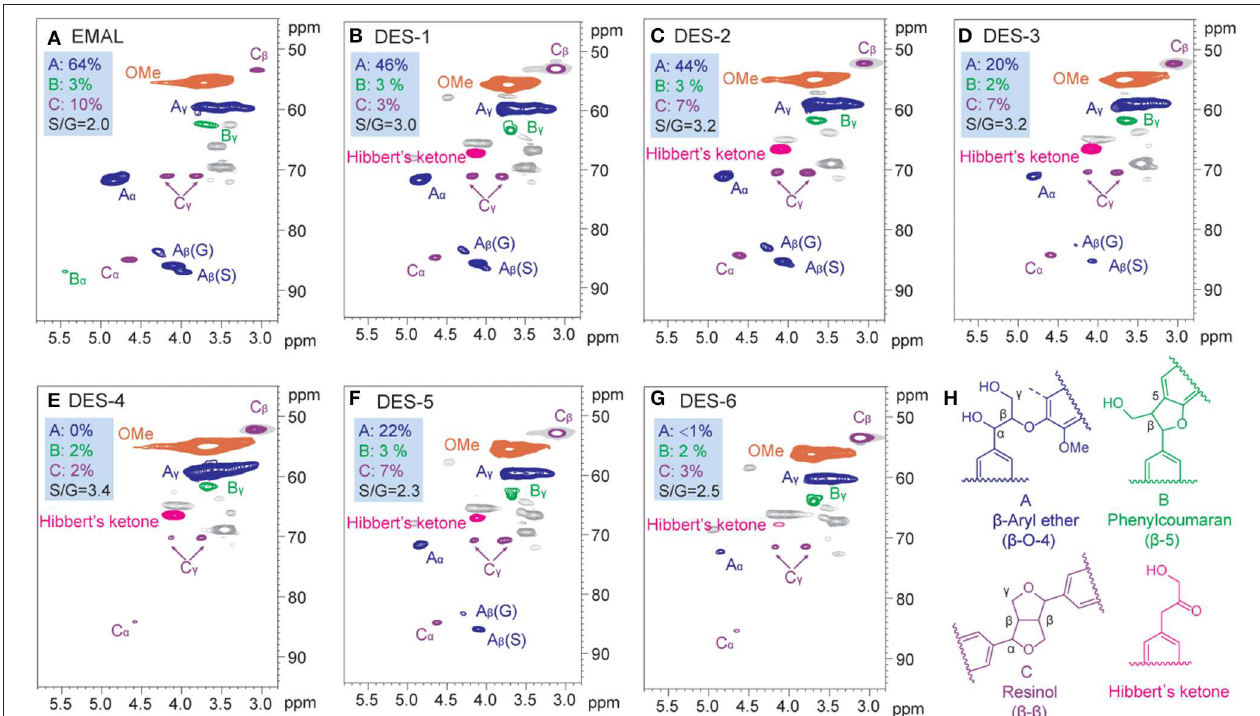
FIGURE 2 | Side chain ( δ C / δ H 45–100/2.8–5.3 ppm) in the two-dimensional (2D) heteronuclear single quantum coherence spectroscopy (HSQC) NMR spectra of regenerated lignin ( RL ) after deep eutectic solvent (DES) treatment. (A) Enzymatic Mild Acidolysis Lignin (EMAL), (B) DES-1 ( Table 1 , entry 2), (C) DES-2 ( Table 1 ,